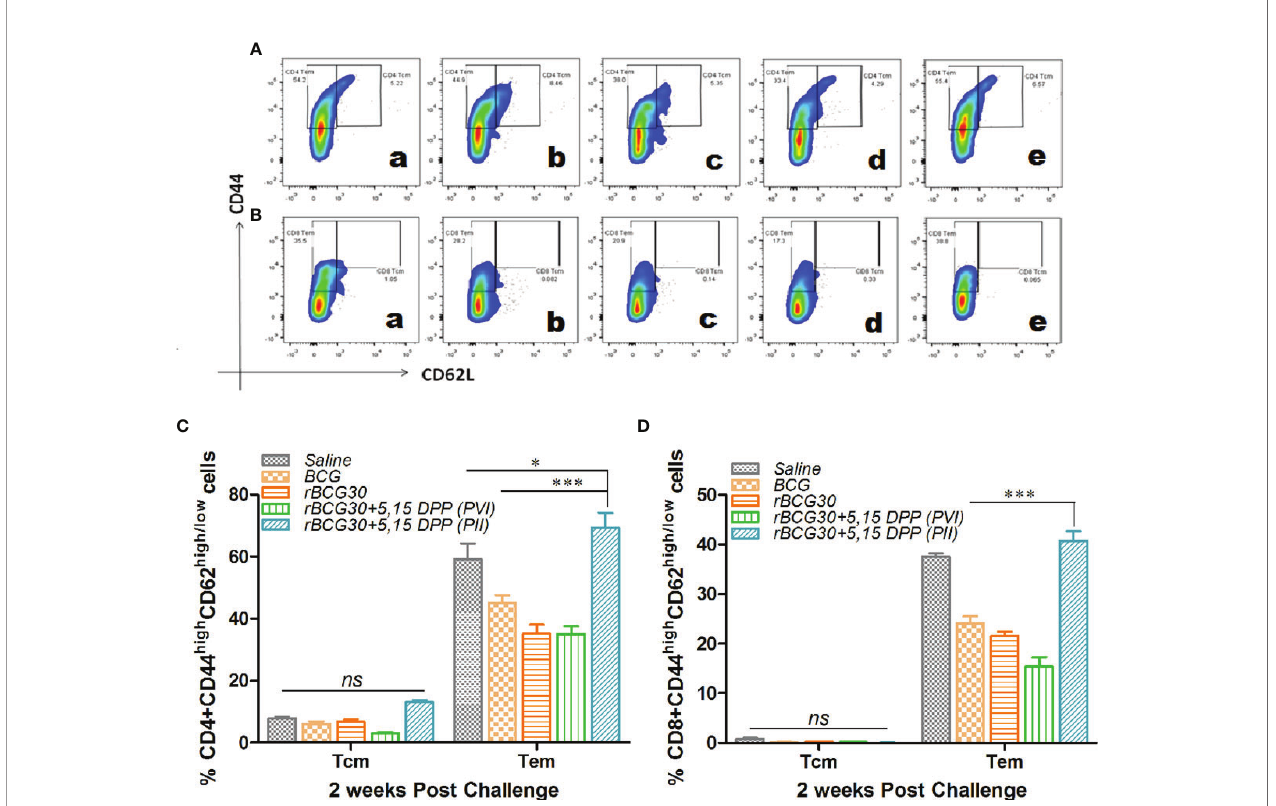
FIGURE 7 | Memory T cell response at week 2 post-challenge. Antigen-speci fi c CD4+ and CD8+ T central and effector memory response was assessed in the splenocytes isolated from various groups at 2 weeks PC. Shown in the fi gure are representative FACS plots depicting cumulative frequencies of (A) CD4+ and (B) CD8+ memory T cells from (a) Saline, (b) BCG, (c) rBCG30, (d) rBCG30+5,15-DPP (PVI), and (e) rBCG30+5,15-DPP (PII) groups, respectively. Bar graphs in the fi gure are depicting comparative magnitude (in percent) of effector memory (CD44 high CD62L low ) (Tem) and central memory (CD44 high CD62L high ) (Tcm) among (C) CD4+and (D) CD8+ T cells. The data were analyzed by employing Two-way ANOVA followed by Bonferroni ’ s multiple comparison test and are shown as means ( ± SEM) from one of the two independent experiments with similar observations performed in at least three biological replicates, where